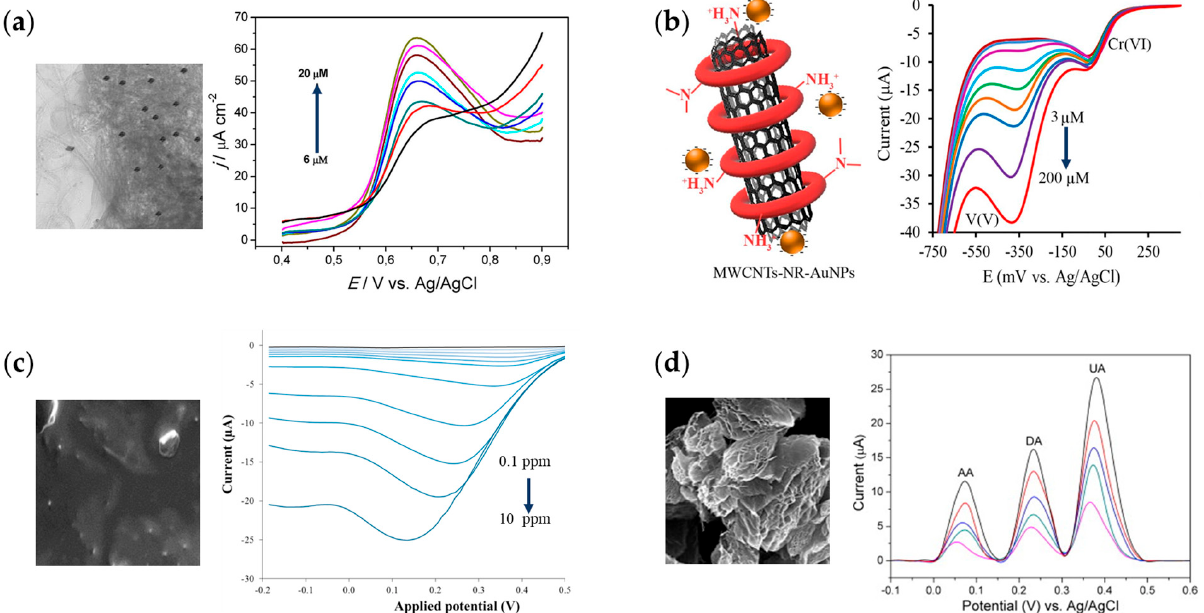
Figure 10. ( a ) Multiwall carbon nanotube/gold nanoparticle mixer for estradiol detection [105]. ( b ) Gold nanoparticles decorated on multiwall carbon nanotube for the detection of Cr and V ions [107]. ( c ) Polyaniline/graphene quantum dot on the screen-printed carbon electrode toward sensitivity of Cr ions [108]. ( d ) Nitrogen–doped graphene for electrochemical detection of ascorbic acid, dopamine and uric acid [110].